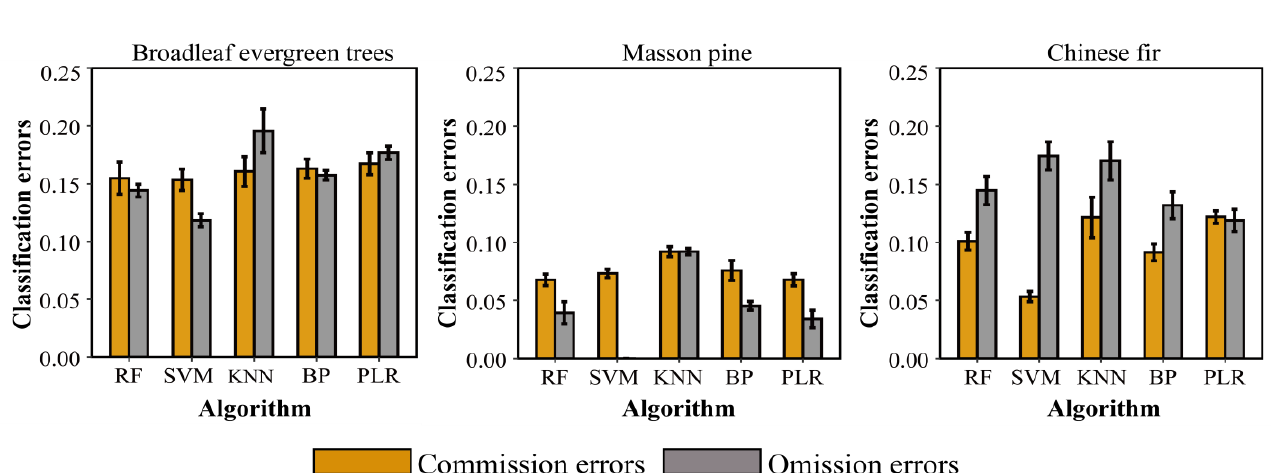
Figure 4. Comparison of identification errors of different tree types.